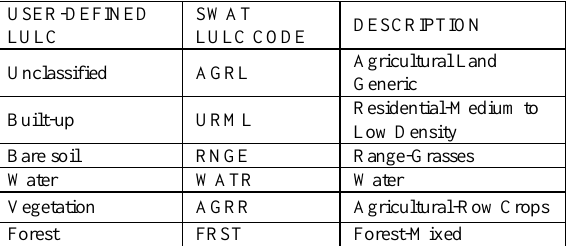
Table 2. User-defined and SWAT LULC classes.